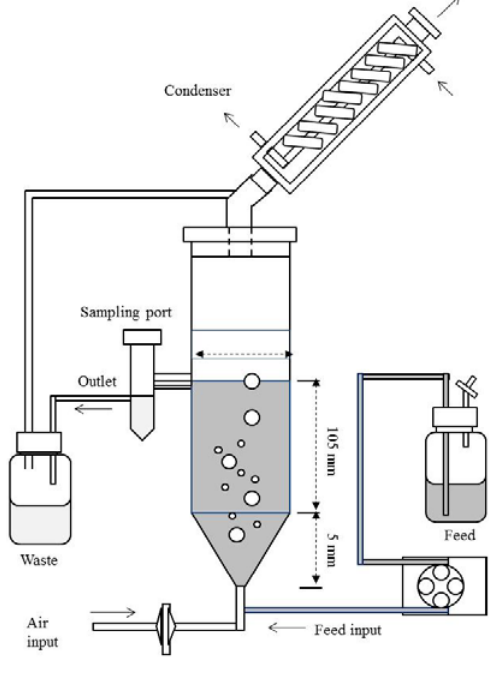
Figure 4. Diagram of the fixed bed reactor used in the present